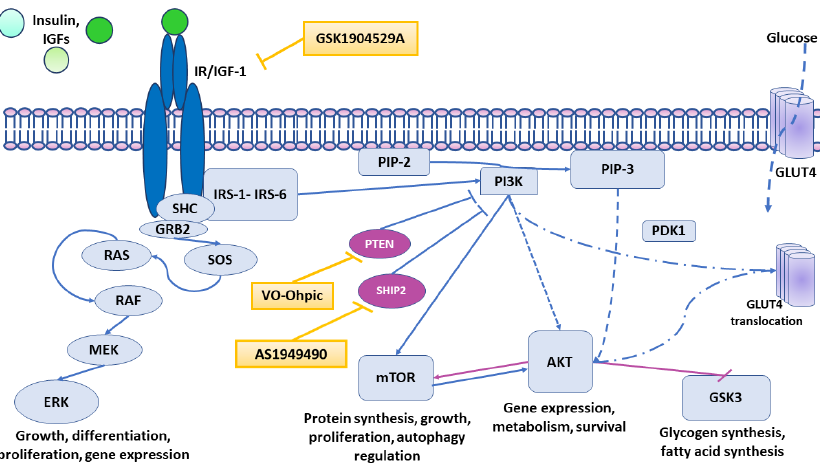
Figure 1. Schematic illustration of the actions of AS1949490, VO-Ohpic and GSK1904529A on downstream signaling of the insulin receptor. GSK1904529A selectively blocks IR and IGF1R au- tophosphorylation, in this way blocking the downstream signaling of IR and IGF1R. VO-Ohpic inhibits PTEN, thereby upregulating PI3K-AKT-mTOR signaling. AS1949490 increases the signaling through the PI3K-AKT-mTOR pathway by selectively inhibiting